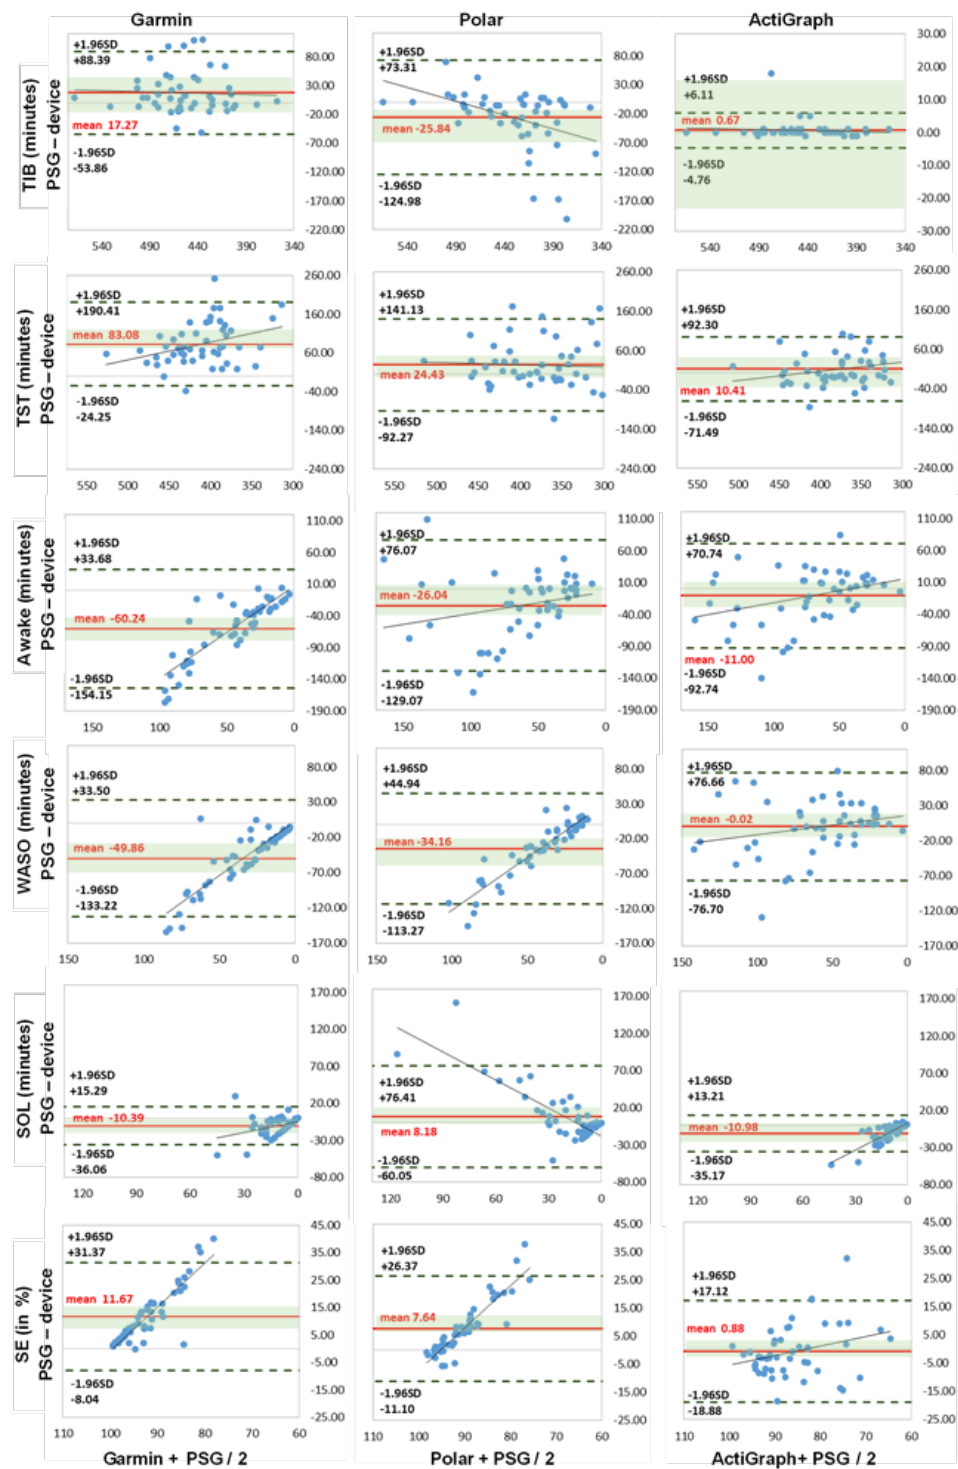
Figure 1. Bland–Altman plots of sleep parameters ( n = 49). TIB = time in bed, TST = total sleep time, Awake = awake time (WASO + SOL), WASO = wake after sleep onset, SOL = sleep onset latency (all expressed in minutes), SE = sleep efficiency (in %). x -axis represents the mean values of the device and PSG; y -axis represents the differences between the PSG and the device; dashed black line represents the upper and lower limit of agreement (mean +/ − 1.96 SD); solid red line represents the mean value of difference; solid blue line represents the trend; shaded green area represents 95% CI (confidence interval) of mean